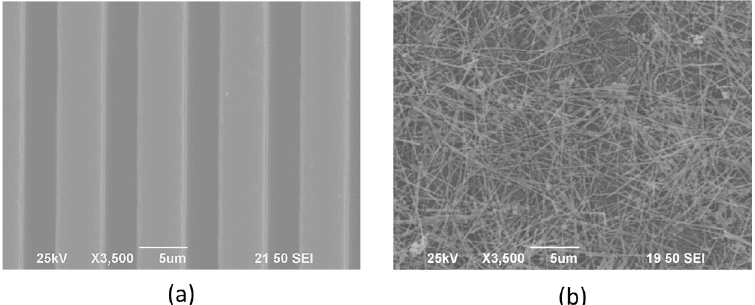
Figure 4. Scanning electron microscope (SEM) image of the fabricated structure before and after post-microelectromechanical system (MEMS) process: ( a ) interdigitated electrodes fabricated by a typical CMOS process, ( b ) silver nanowires deposited on the top of the structure.